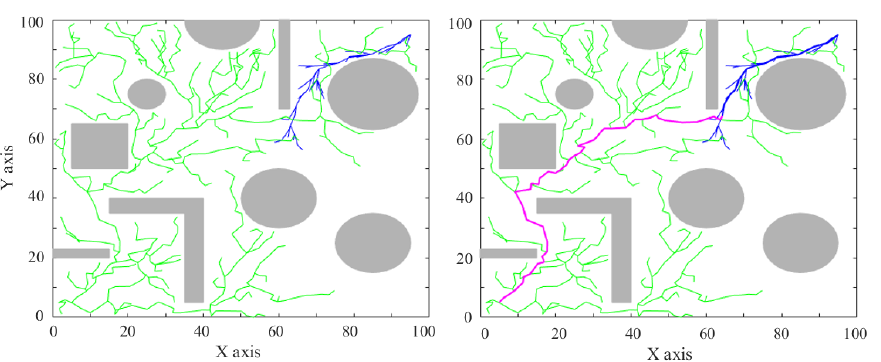
Figure 16. Tree expanded from the gsoal and the planned path. (( left ) The green T of fline and the blue T goal , ( right ) the magenta part in T of fline and the blue part in T goal are combined to obtain a path from the starting point to the